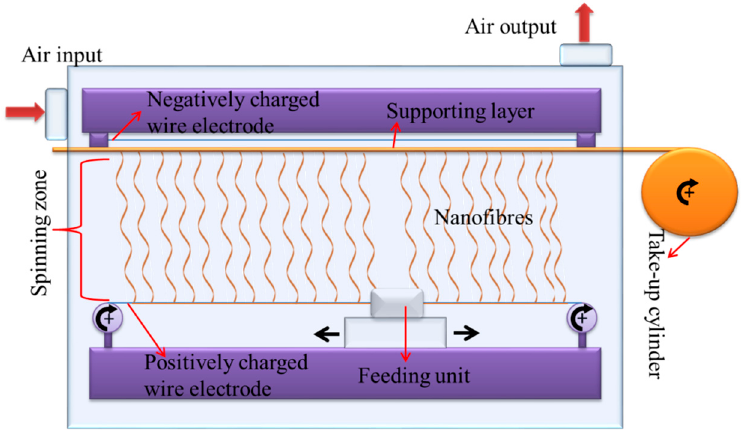
Figure 1. Schematic diagram of the needle-free electrospinning device.